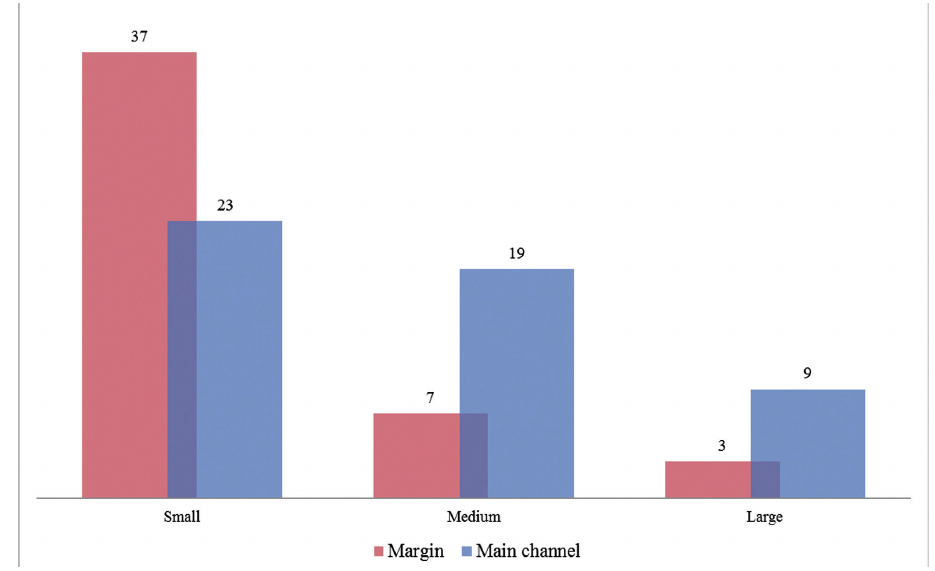
FIGURE 2 | Distribution of sizes classes of fish from Serra da Bodoquena stream according to instream horizontal